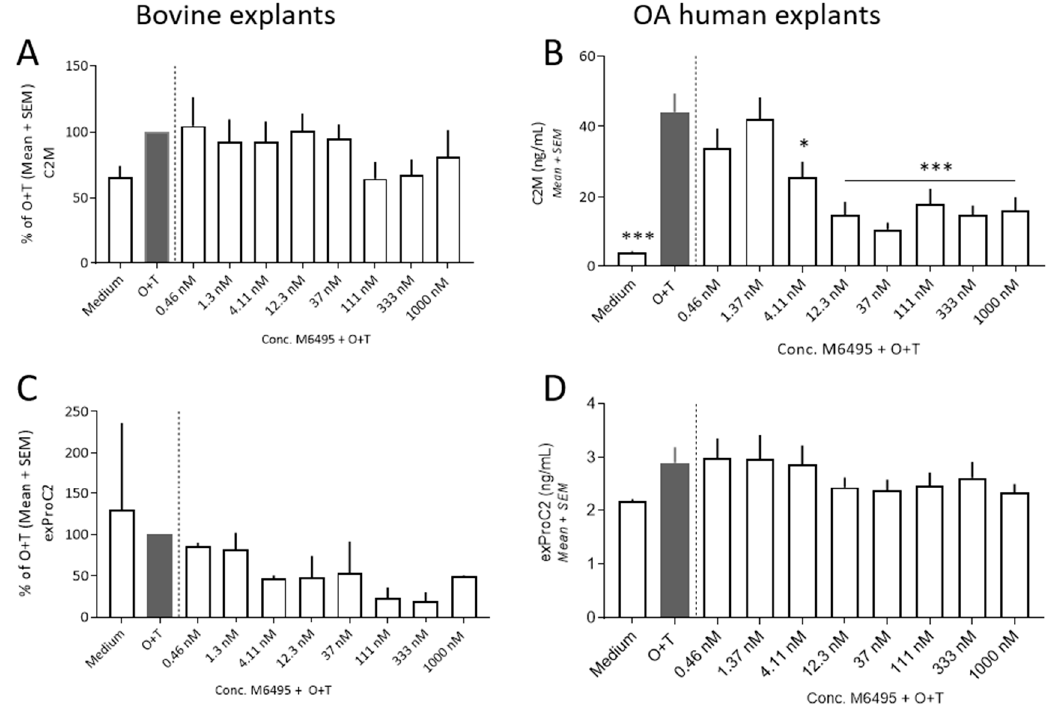
Figure 3. Cartilage turnover in bovine cartilage explants and OA human cartilage explants at day